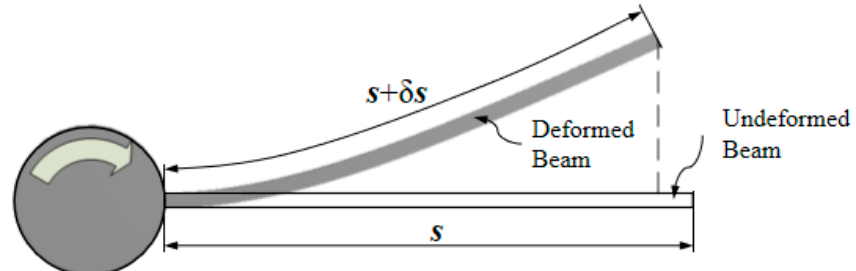
Figure 1. Beam foreshortening effect.